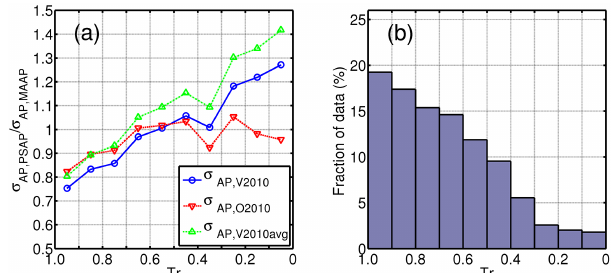
Figure 4. The influence of the PSAP’s filter transmittance (Tr) on σ AP in comparison to σ AP from the MAAP and data coverage. (a) The median fraction of σ AP calculated using the V2010 (blue), O2010 (red) and V2010avg (green) corrections in comparison to the MAAP ( σ AP,MAAP ). (b) The percentage of data points for a given Tr